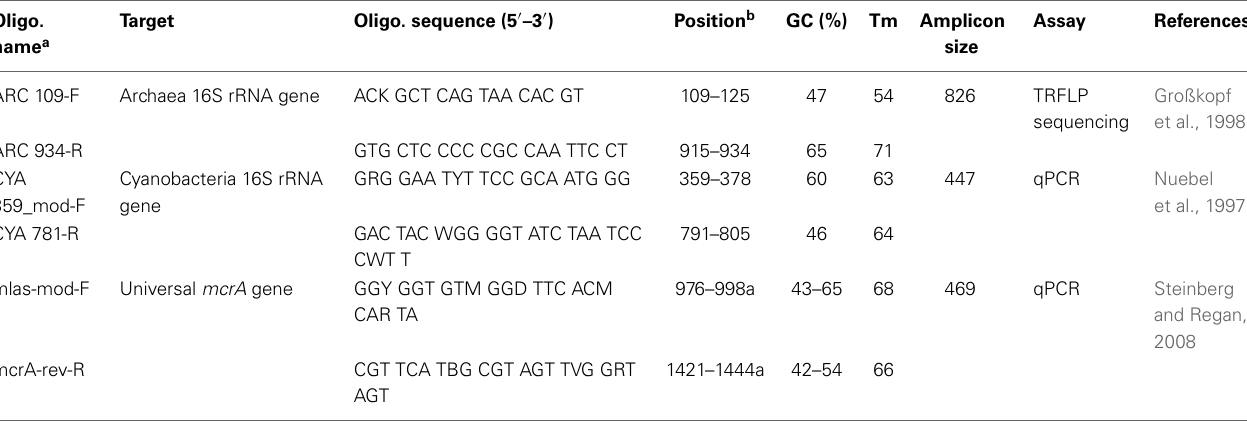
Table 2 | Overview of the used primers in this study.